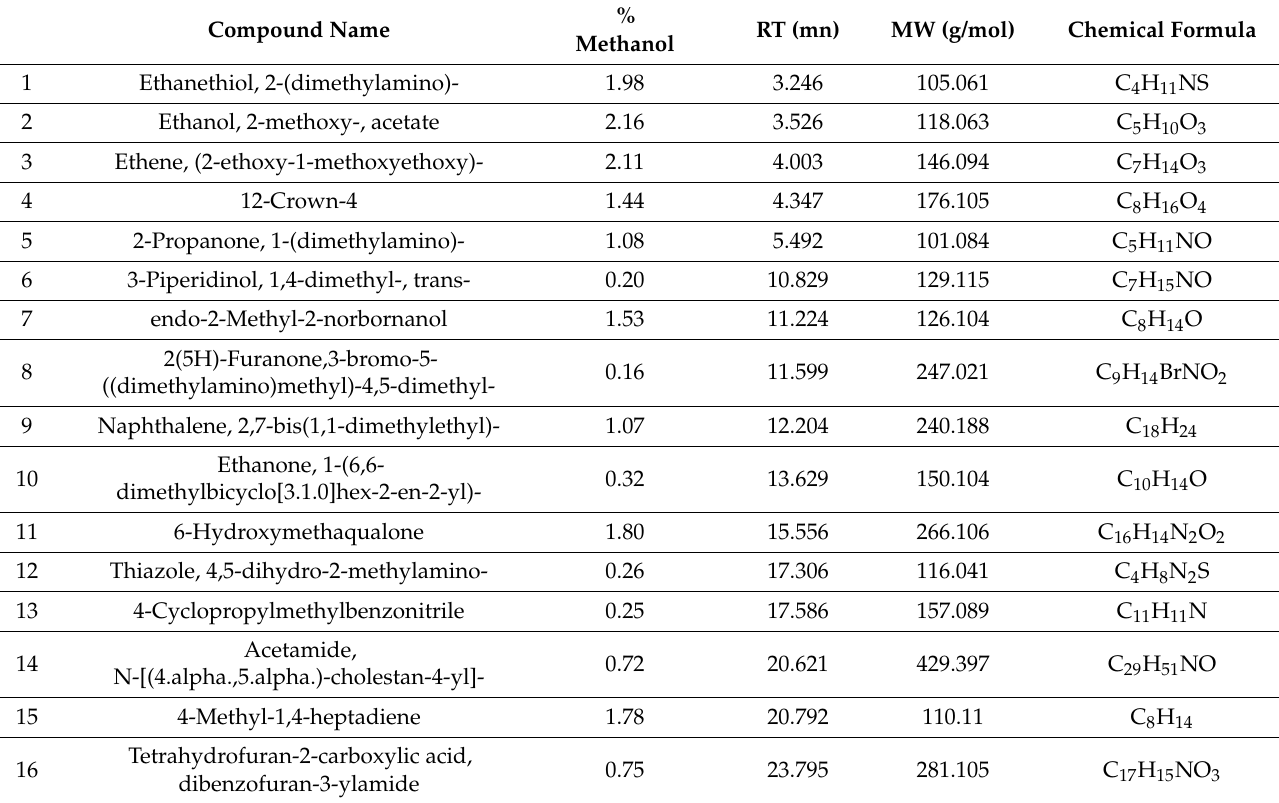
Table 1. Chemical composition of the compounds that are present only in the methanolic R. epapposum